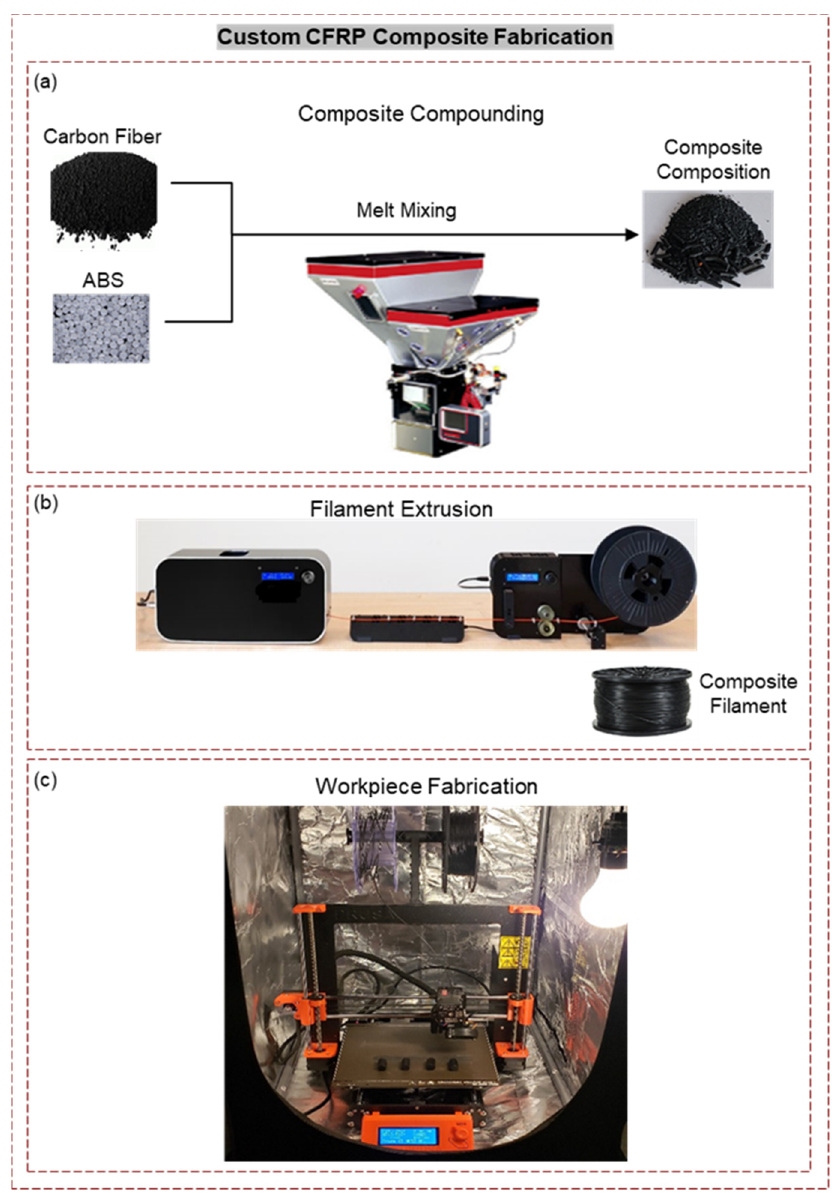
Figure 1. Custom CFRP Composite Fabrication Process ( a ) Melt Mix Compounding ( b ) Filament Extrusion ( c ) Sample Fabrication.